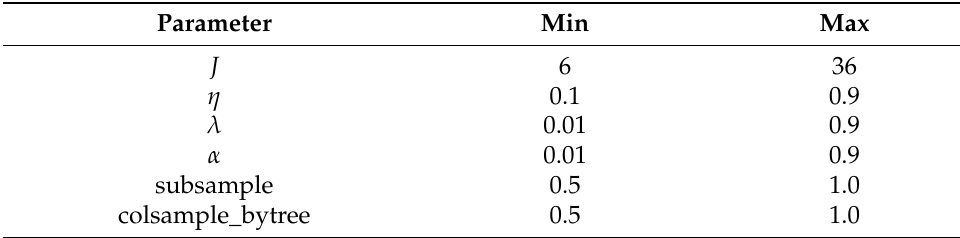
Table 2. Parameter search